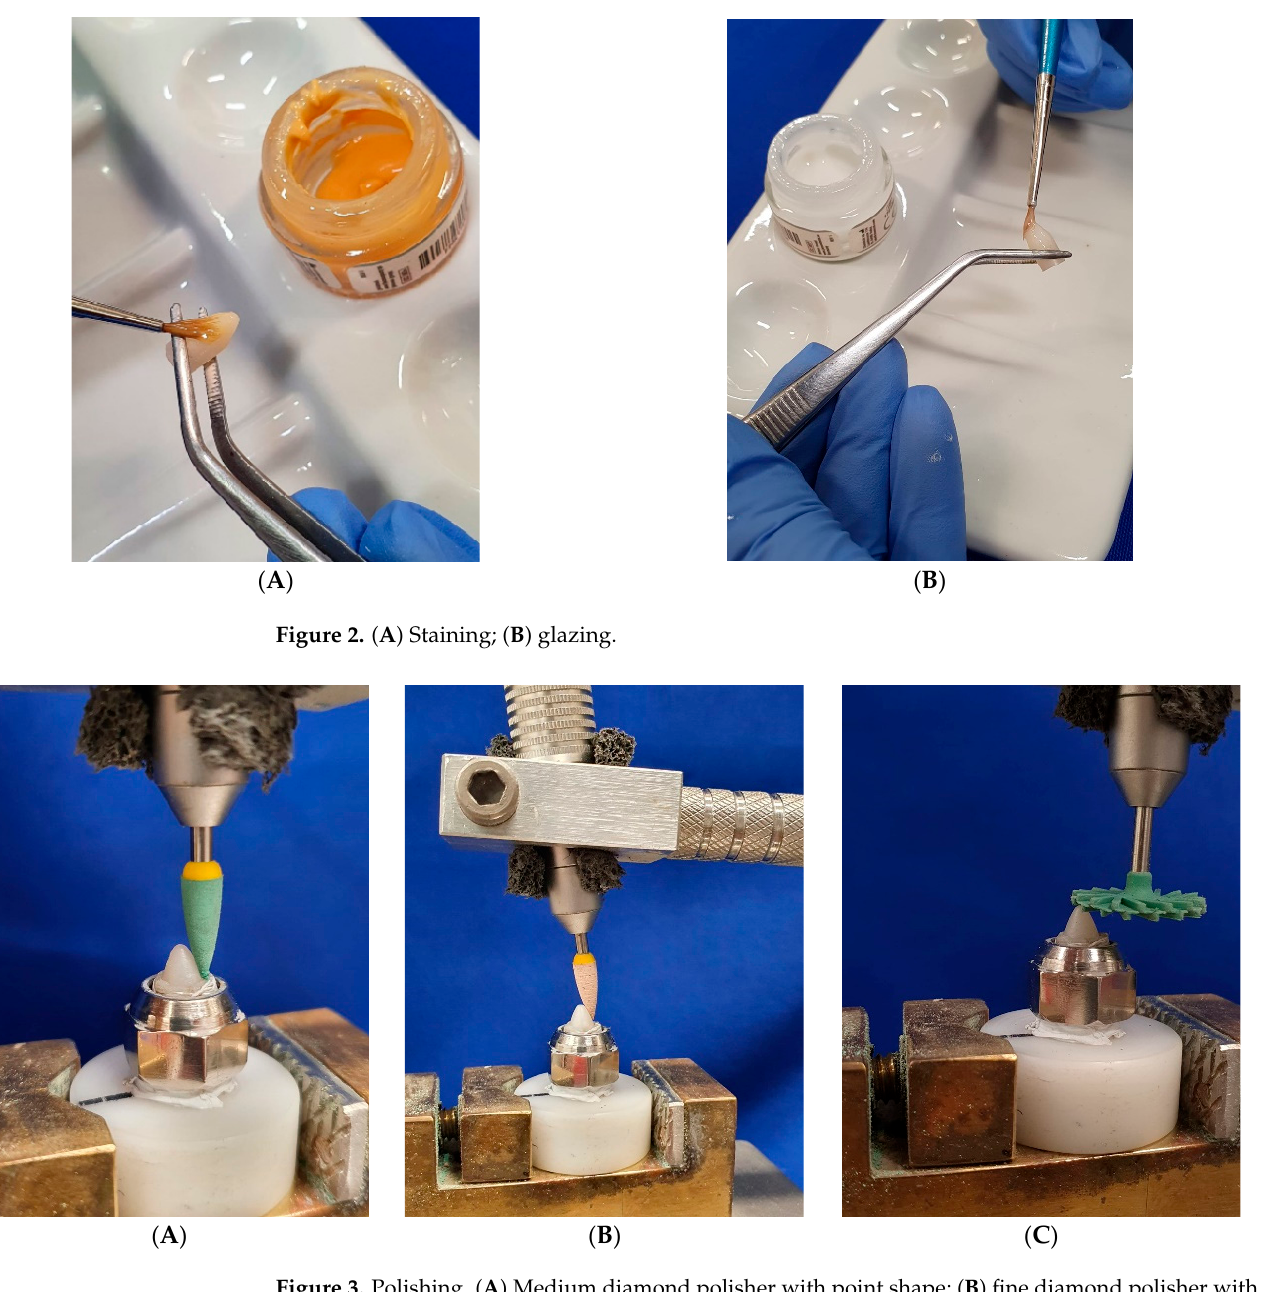
Figure 3. Polishing. ( A ) Medium diamond polisher with point shape; ( B ) fine diamond polisher with point shape; ( C ) medium diamond polisher with twist shape.